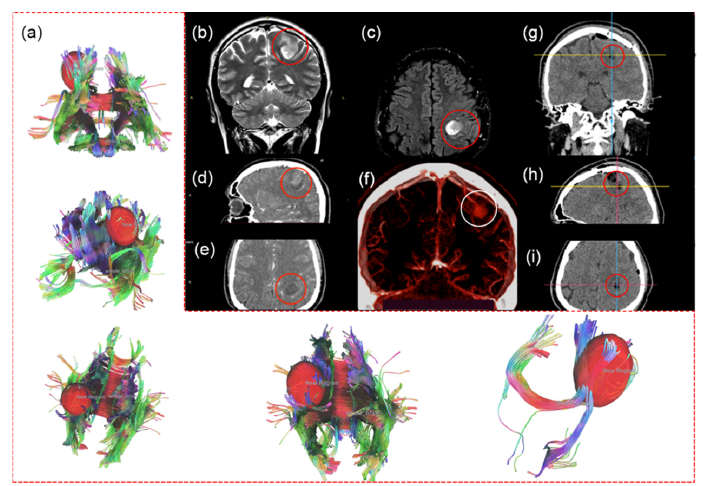
Figure 1. MRI, fMRI, and CT before first surgery. fMRI with involvement of the left pyramidal tract in the pathological process ( a ). MRI (1.5 T) of the tumor of the left parietal lobe (red circle): T2 coronal ( b ), T2 flair axial ( c ) projections. CT with contrast enhancement: tumor of the left parietal lobe with contrast uptake (red circles): sagittal ( d ), axial ( e ) projections. CT angiography ( f ): emissary vein to sagittal sinus (white circle). CT images on the first day after the first surgery: coronal ( g ), sagittal ( h ), and axial ( i ) projections. Total resection of the tumor in the left parietal lobe, no tumor, and no contrast uptake in the tumor